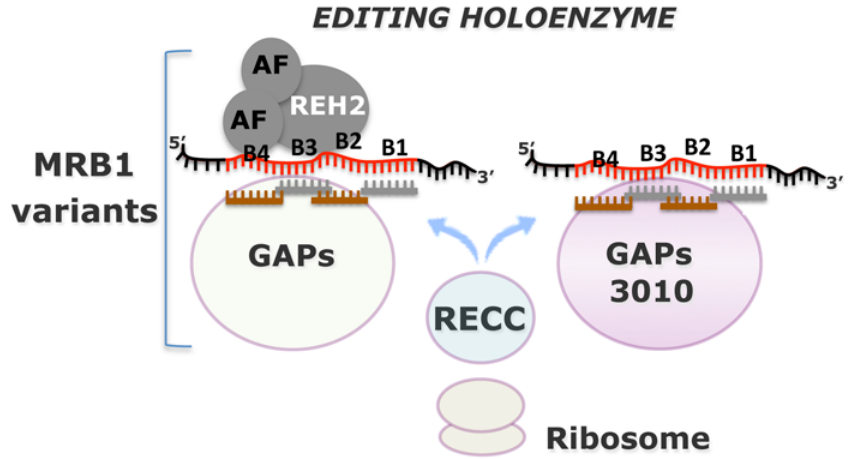
Fig 11. Model of MRB1 function and organization. MRB1 complexes carry editing substrates (pre-mRNA and gRNA), partially-edited intermediates and fully-edited mRNA, core GAP1/GAP2 proteins (GAPs), and other common and variable proteins. Addition of the RECC enzyme to MRB1 scaffolds forms the editing holoenzyme. Two MRB1 variants, REH2-MRB and 3010-MRB are structurally and functionally distinct. 3010-MRB appears to be a more active editing scaffold than REH2-MRB. REH2-MRB includes the regulatory REH2 helicase that affects 3010-MRB at multiple steps: mRNA substrate loading, and maturation at block 1 and subsequent blocks during editing progression. REH2 binds RNA and REH2 ’ s association with other MRB1 components is mediated by bridging RNA and the helicase catalytic and RNA-binding domains. REH2 can be further isolated in a “ RNA-free ” ~15S subcomplex with a ~30 kDA RNA binding cofactor and, potentially, with other associated cofactors (AFs). The editing domain in mRNAs typically spans multiple blocks (e.g., B1-to-B4), each directed by a gRNA. Transient contacts between RECC and MRB complexes imply that catalysis involves multiple rounds of enzyme association and dissociation with the MRB